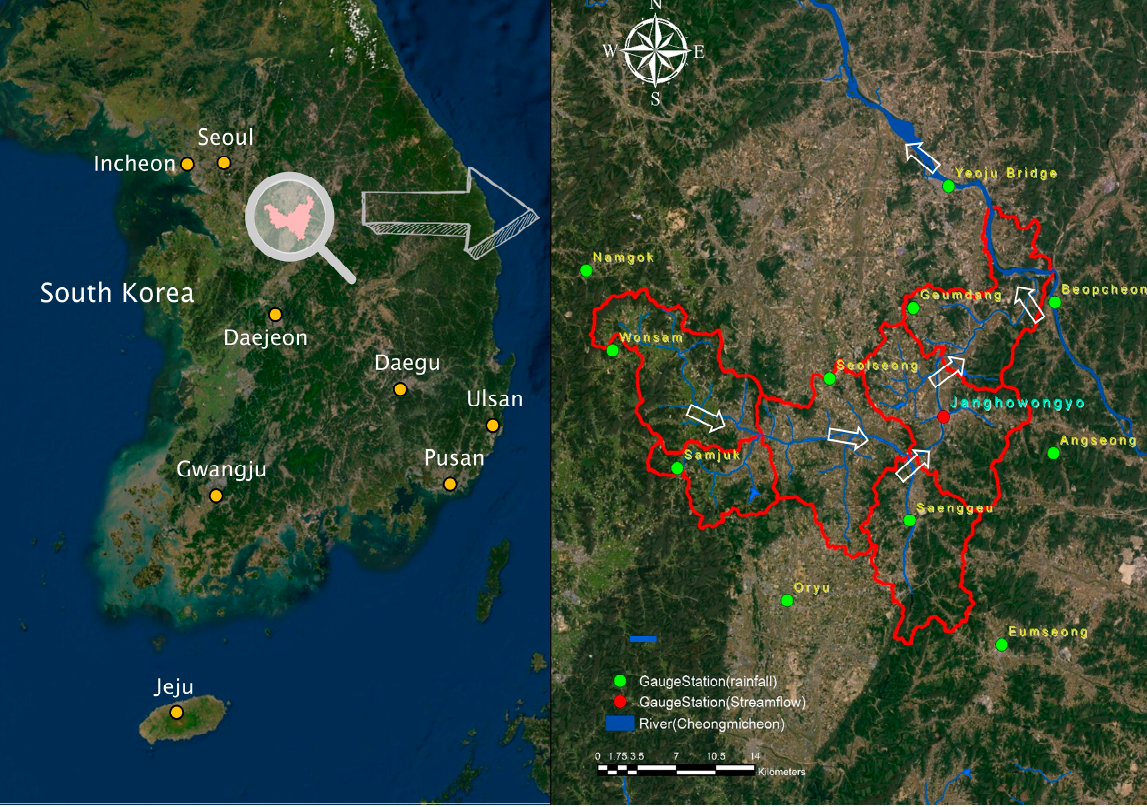
Figure 1. Hydrologic network of Study area.